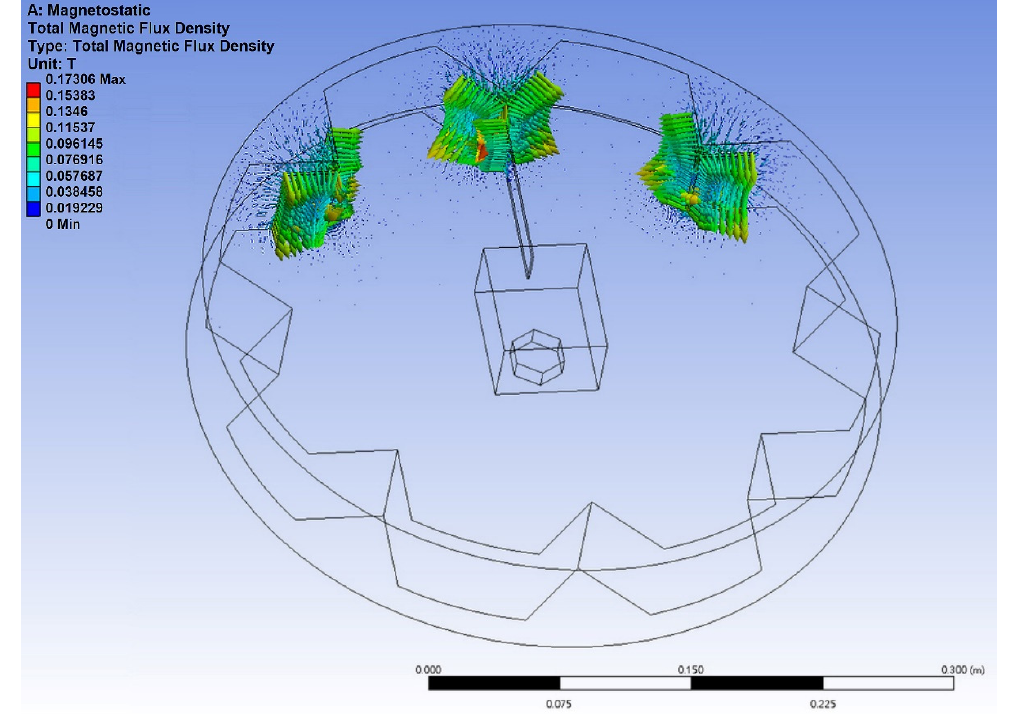
Figure 5. Distribution of magnetic flux.